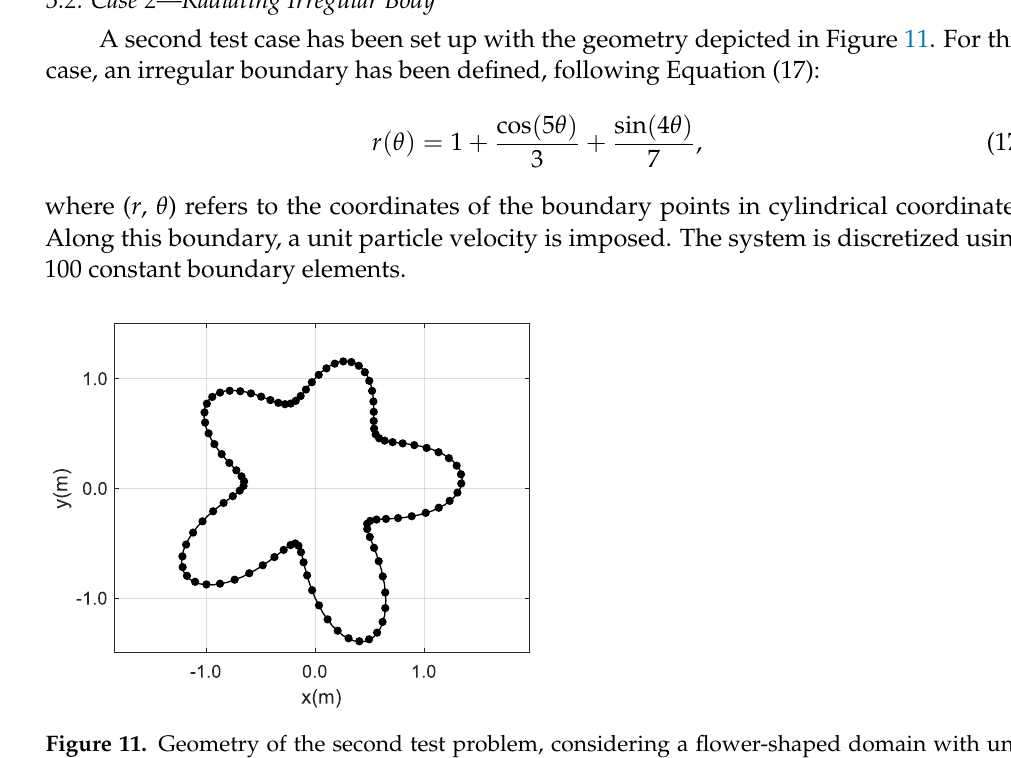
Figure 10. Final position of the CHIEF points after the optimization procedure considering min (SV) > 0.3: ( a ) ALG1, requiring six points; ( b ) ALG2, requiring 10 points.